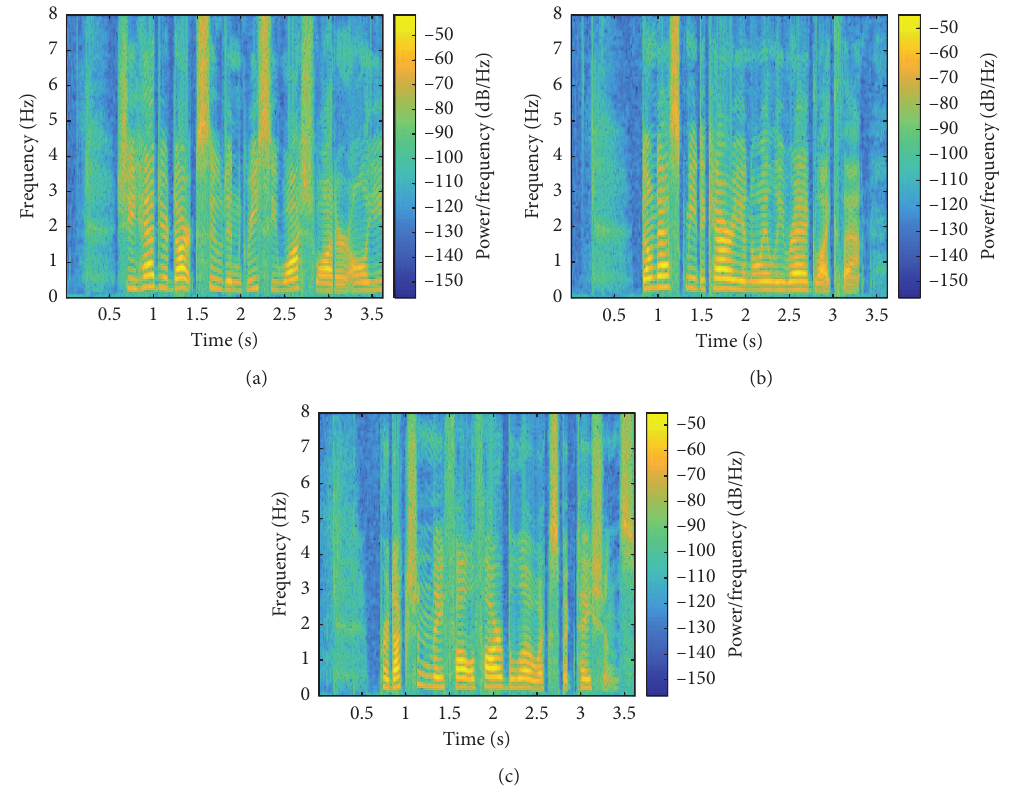
Figure 13: Spectrograms of source signals (three speech signals): (a) SA1 speech signal; (b) SA2 speech signal; (c) SI943 speech